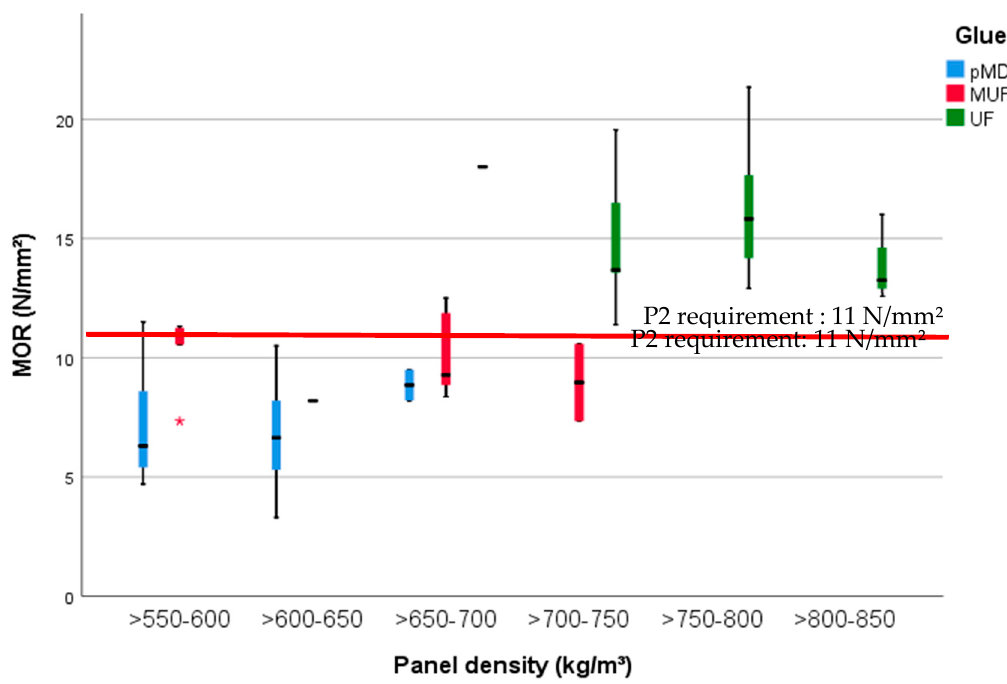
Figure 5. MOR of the 15 mm PB samples with densities between 500 and 850 kg/m³ and glued with pMDI, UF and MUF.